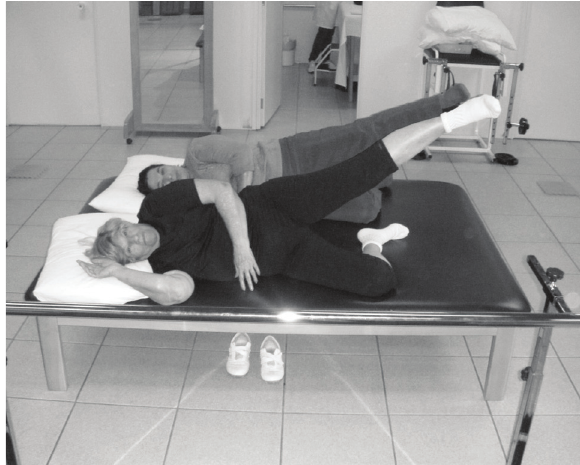
Figura 5 - Demonstração de exercícios de cadeia muscular lateral na FT Fonte: Dados da pesquisa.